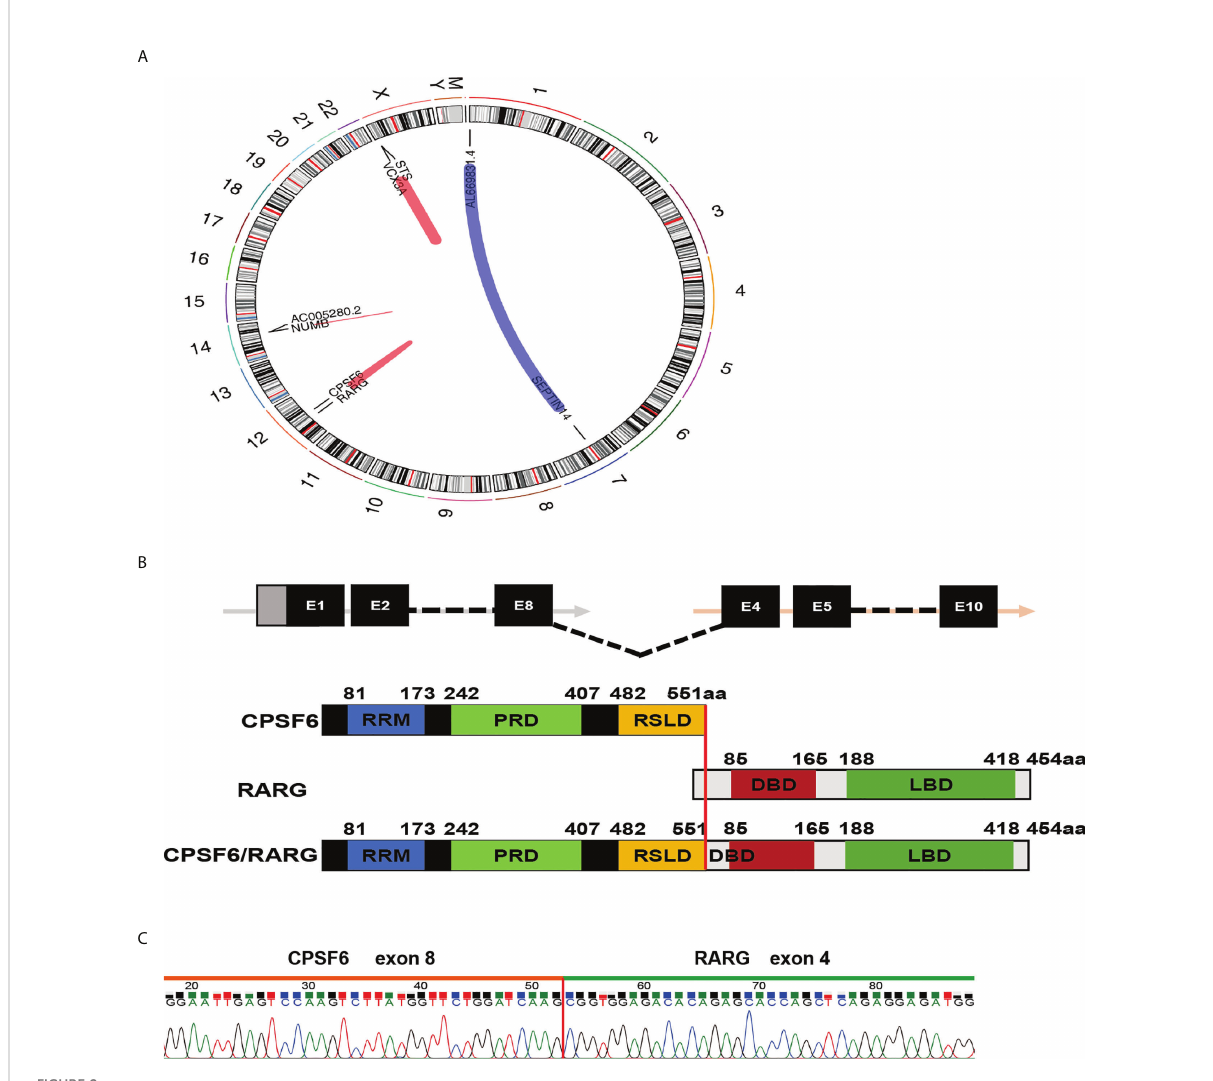
FIGURE 2 Molecular analysis of the CPSF6-RARG fusion. (A) Four fusion genes were found by analyzing RNA-sequencing data of the patient ’ s BM sample using deFuse inspector software. (B) Schematic diagram of CPSF6, RARG, CPSF6 – RARG fusion transcript, and the fusion protein of the patient. The breakpoint is indicated by a red line. (C) Sanger sequencing of the PCR product analysis of the CPSF6 – RARG fusion transcript junctions revealed a fusion between exon 8 of the CPSF6 gene and exon 4 of the RARG